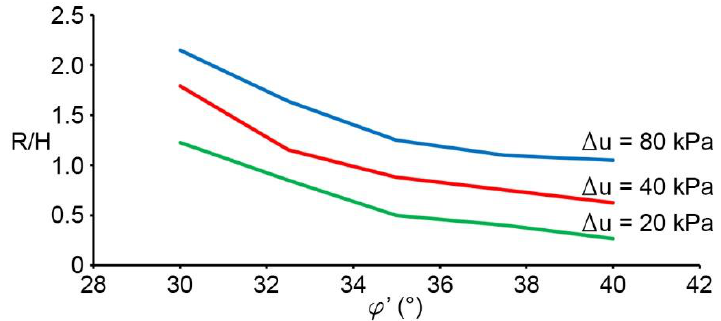
Figure 12. Dimensionless post-failure profile ( a ) and slip surface location ( b ) for the case with H = 5 m, α = 15°, Δu = 40 kPa , and different values of φ’ .